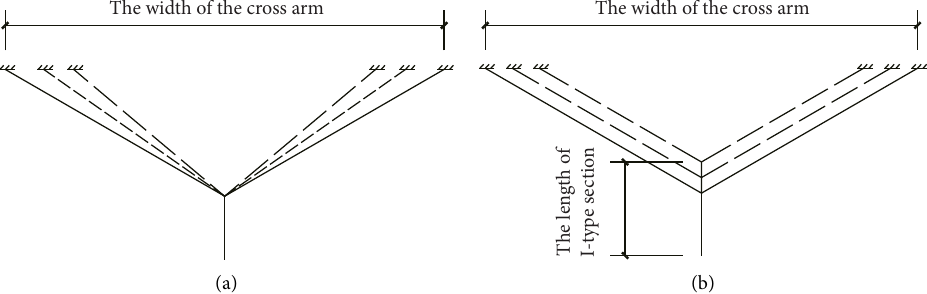
Figure 14: (a) Te structure optimization scheme 1 of the Y -type insulator string. (b) Te structure optimization scheme 2 of the Y -type insulator string.